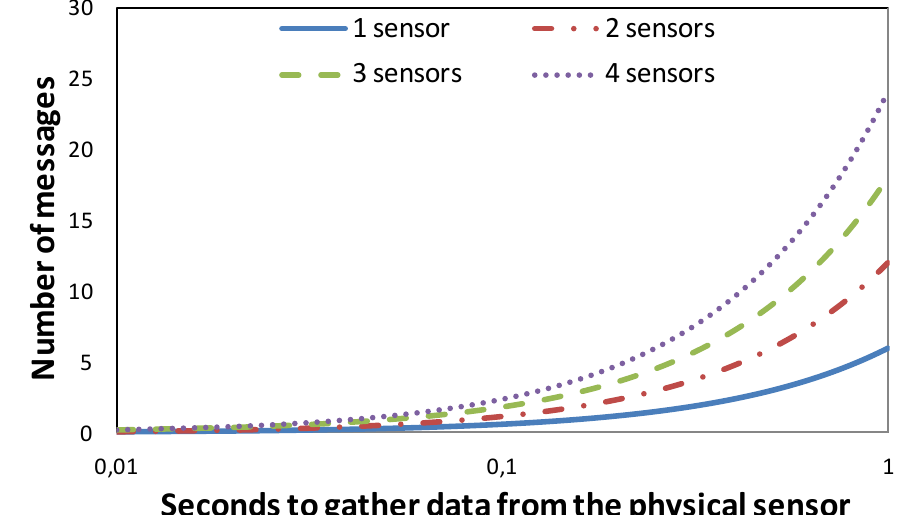
Figure 8. Number of messages in our system as a function of the number of household